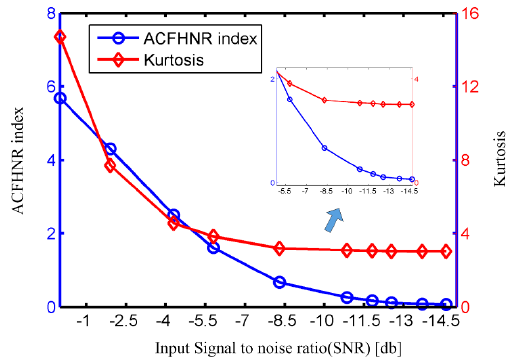
Figure 2. The comparative simulation of the proposed ACFHNR index and the kurtosis.